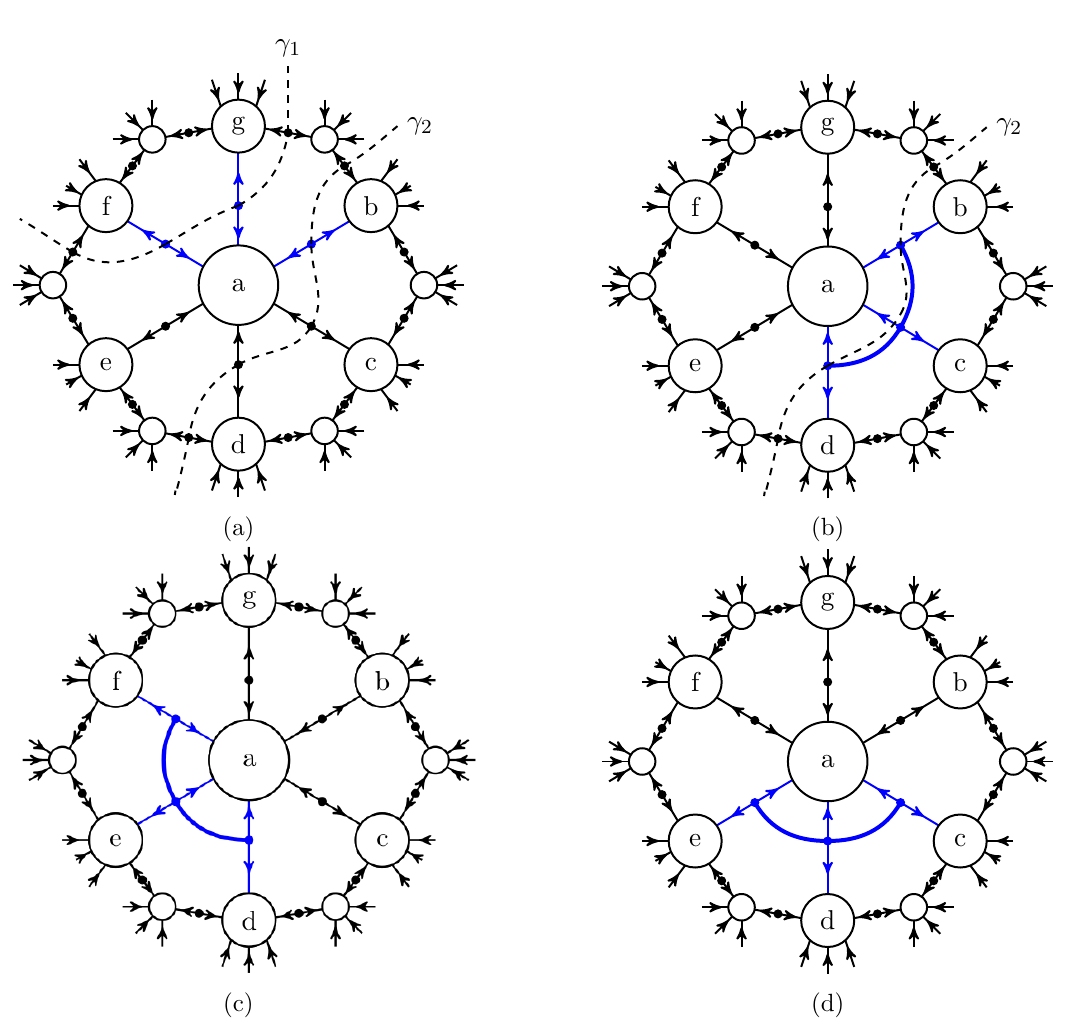
Figure 11. The four networks included in the set F considered in text. The projecting states shown in blue in (a) are defined by an operator O acting on the maximally entangled state, these can be pushed to any subset of three legs, as seen in (b-d). In general the pushed through operator will not have a tensor product structure, so the corresponding projecting state will be entangled across three legs. This is indicated here by the thick blue line in (b-d). All four networks shown here have the same boundary state. The entropies of subsets of boundary legs is calculated by choosing the network which contains an isometric cut enclosing those boundary legs, and applying the isometric cut formula. No one network contains an isometric cut for every boundary region, but the set of four networks together